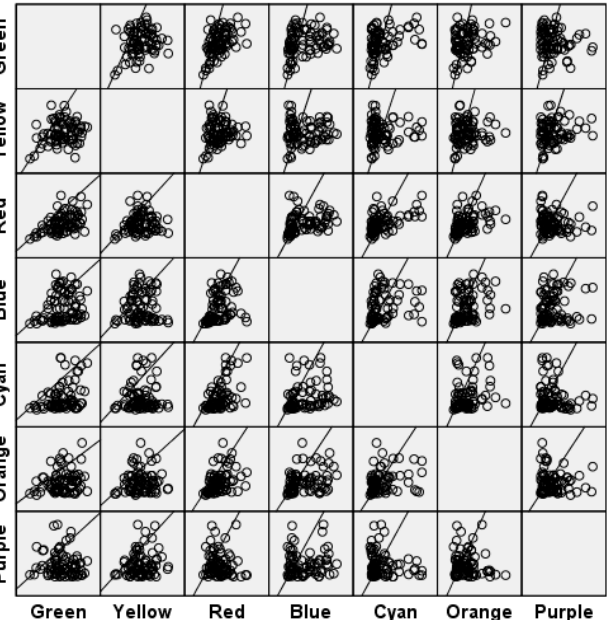
Figure 4. Influence factor of interest between colours scatter plot matrix. Source: Data exported from ErgoLAB program, SPSS software.